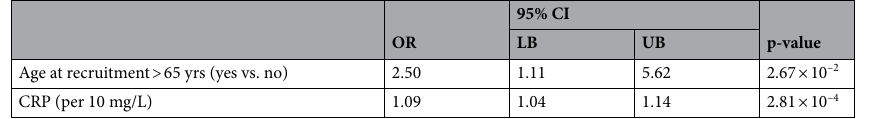
95% CI p-valueLB UB